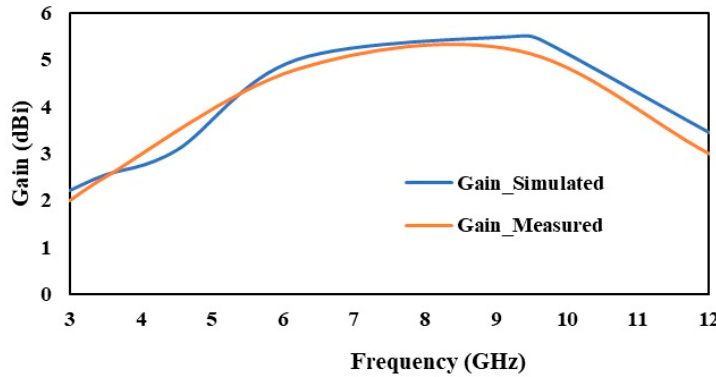
Figure 13. Gain vs. frequency graph of the proposed UWB antenna.